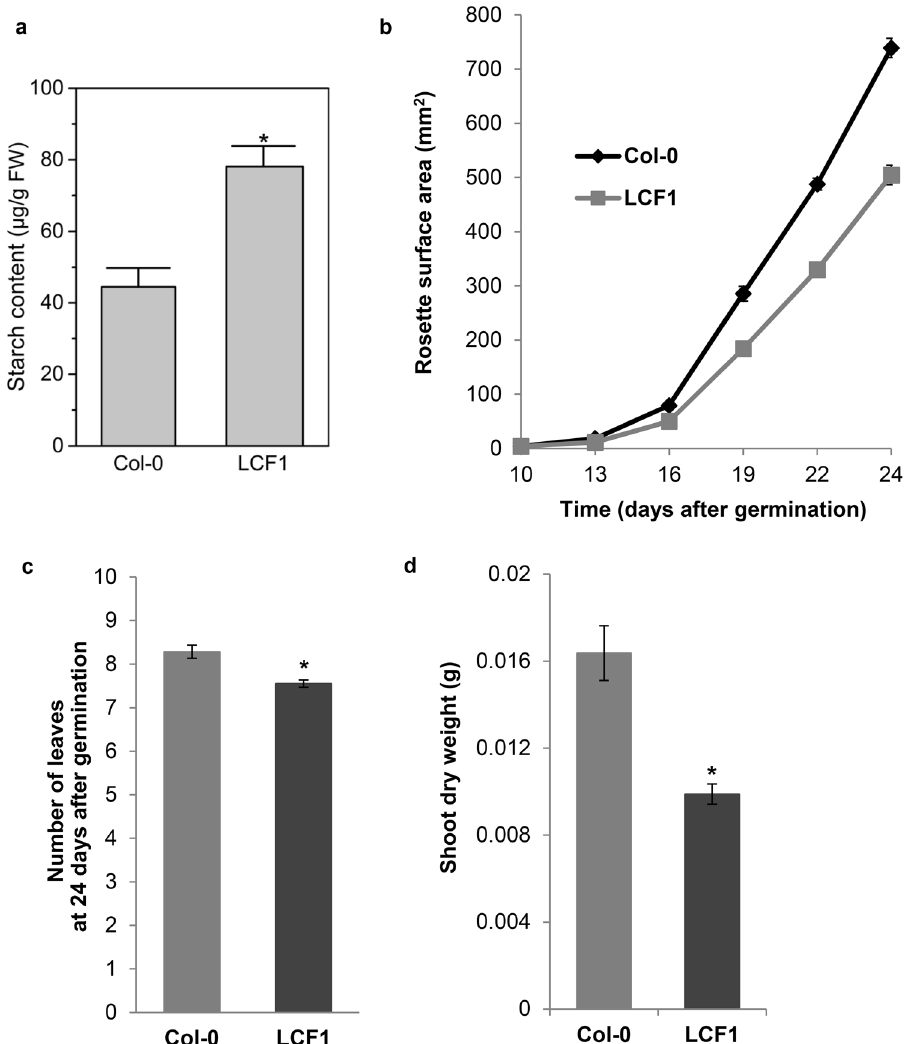
Figure 6. ( a ) Starch content of Col-0 and LCF1 plants at 28 days after germination (n = 3 per genotype). Starch concentration was determined through enzymatic digestion with α -amylase and α -amyloglucosidase, followed by the quantification of glucose concentration by spectrophotometry. Asterisk ( * ) represents a significant difference with Col-0, as determined by one-way ANOVA analysis (p < 0.01). ( b ) Growth curves of Col-0 and LCF1 plants. Error bars represent SEM values (n = 36 for Col-0, n = 99 for LCF1), and are only visible when exceeding the data points. ( c ) Number of true leaves with discernable petioles at 24 days after germination. Error bars represent SEM values (n = 35 for Col-0, n = 103 for LCF1. ( d ) Dry weight of Col-0 and LCF1 shoots at 24 days after germination. Error bars represent SEM values (n = 24 for Col-0, n = 69 for LCF1). Asterisks ( * ) represent a significant differences with Col-0 ( p <